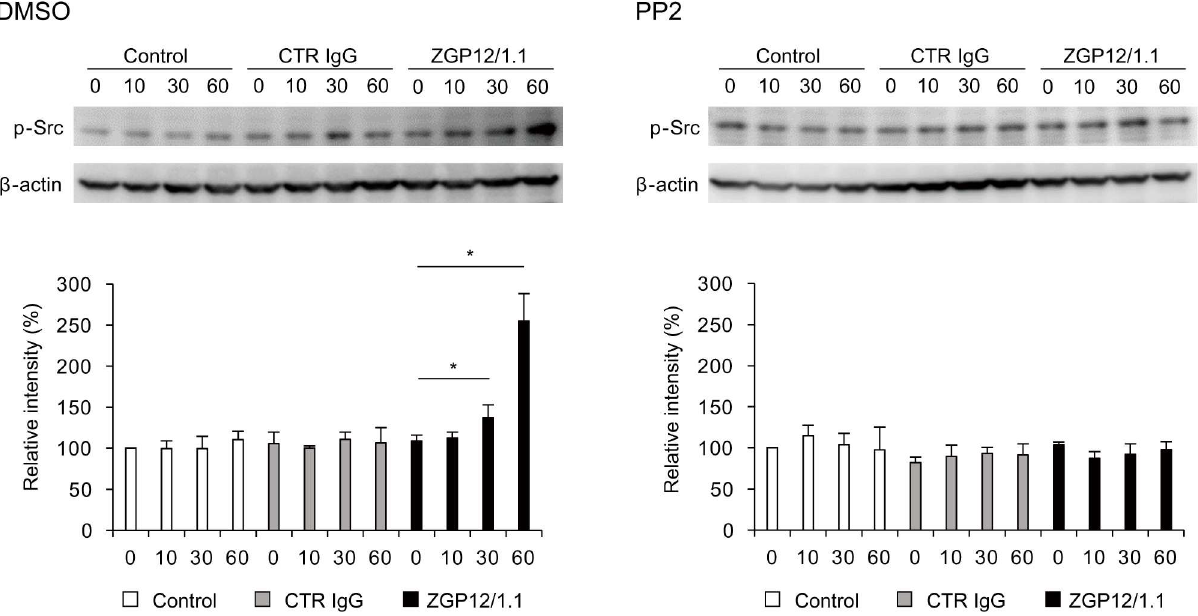
Fig 5. Increased phosphorylation of Src in K562 cells exposed to the VLP-ZGP12/1.1 complex. Purified VLPs were preincubatedwith medium alone (Control), CTR IgG, or ZGP12/1.1 and inoculated into K562 cells pretreatedwith DMSO or PP2 for 1 h at 37˚C. At 0, 10, 30, and 60 min postinoculation, phosphorylationof Src at Tyr416 (p-Src) was detected by Western blotting. The band intensity of p-Src was standardized with that of the β -actin bandat each time point. Relativeintensities of the p-Src bandswere then calculatedby setting the intensity of control cells (0 h) to 100%. The mean and standard deviationof three independent experiments are shown. Statistical analysis was performed using Student’s t -test ( * p <